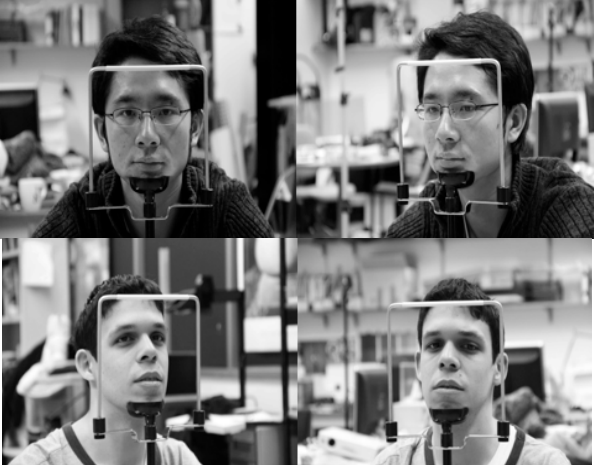
Figure 22. Various head pose image pairs selected from CAVE-DB.